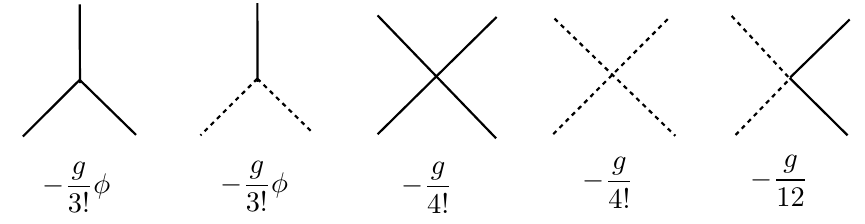
Figure 2 . The vertices for the spontaneously broken phase of the O ( N ) model.